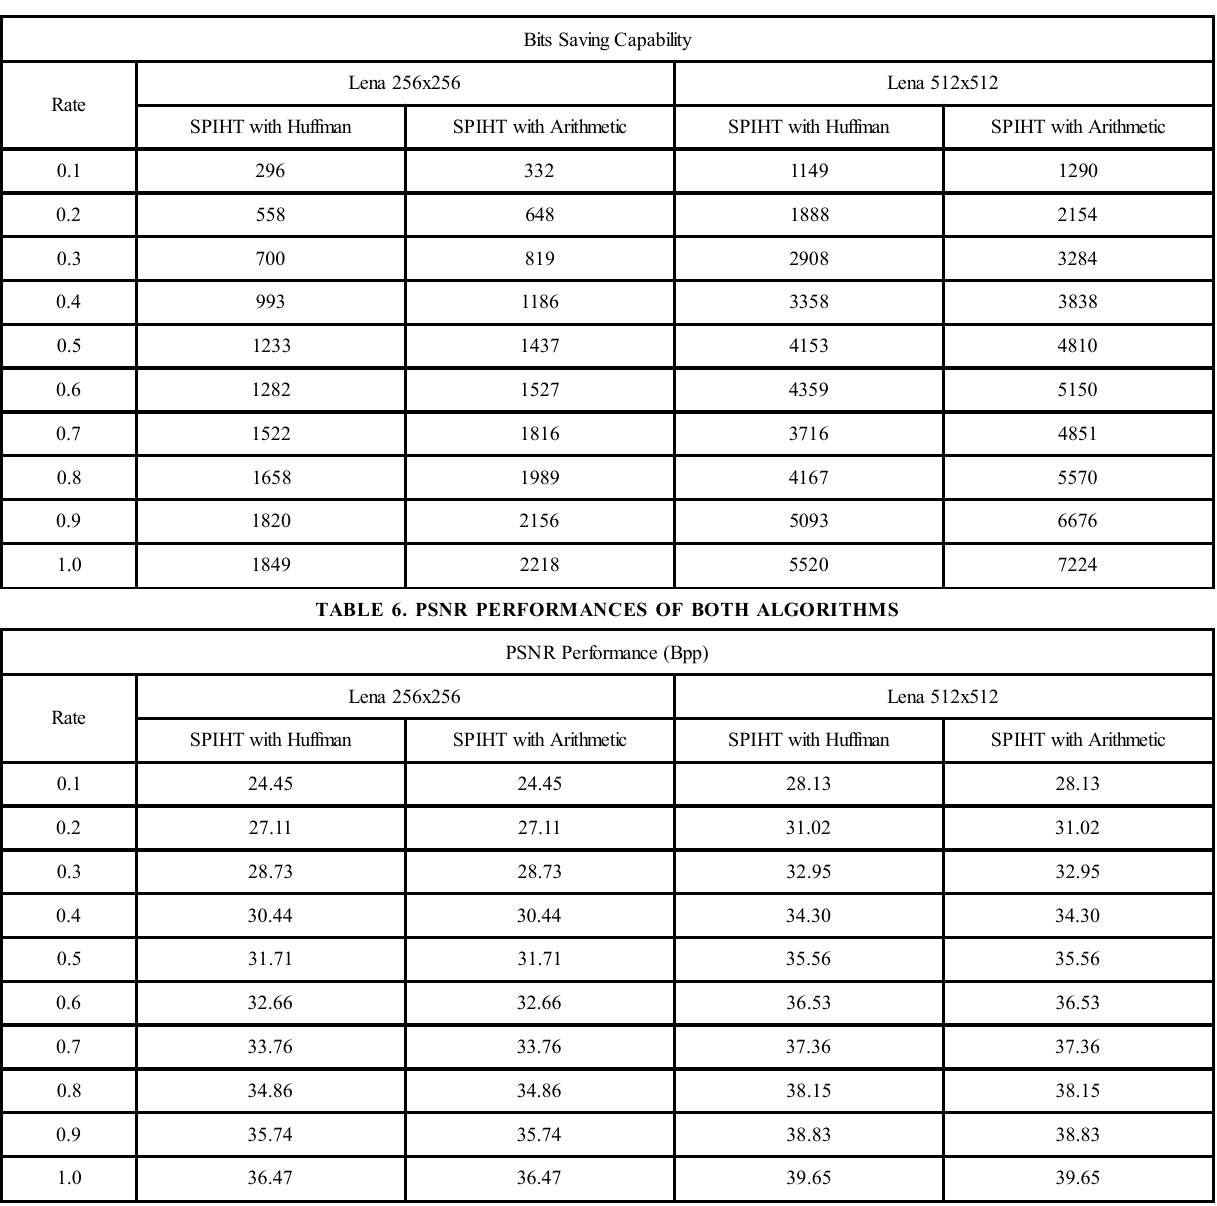
TABLE 5. BITS SAVING CAPABILITY OF BOTH ALGORITHMS